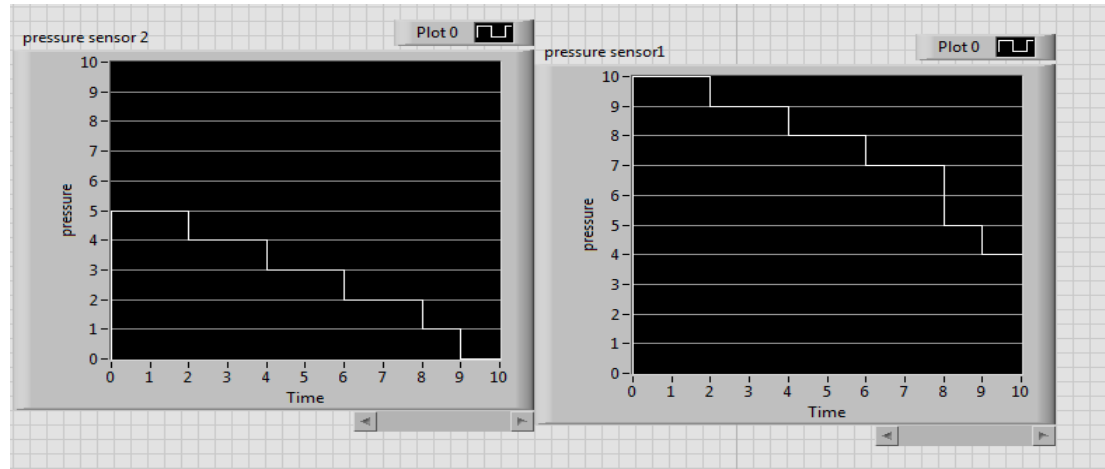
Fig. 15. the trend in pc screen